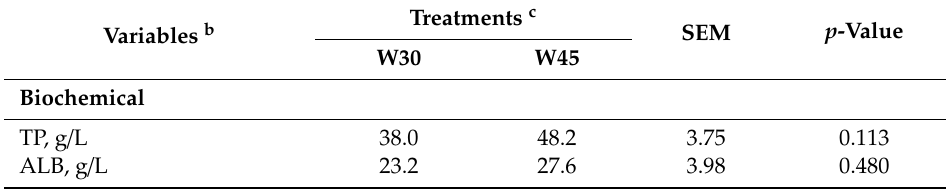
Table 1. Concentrations of plasma measurements in growing lambs at weaning (at d 30 for W30; at d 45 for W45) a .